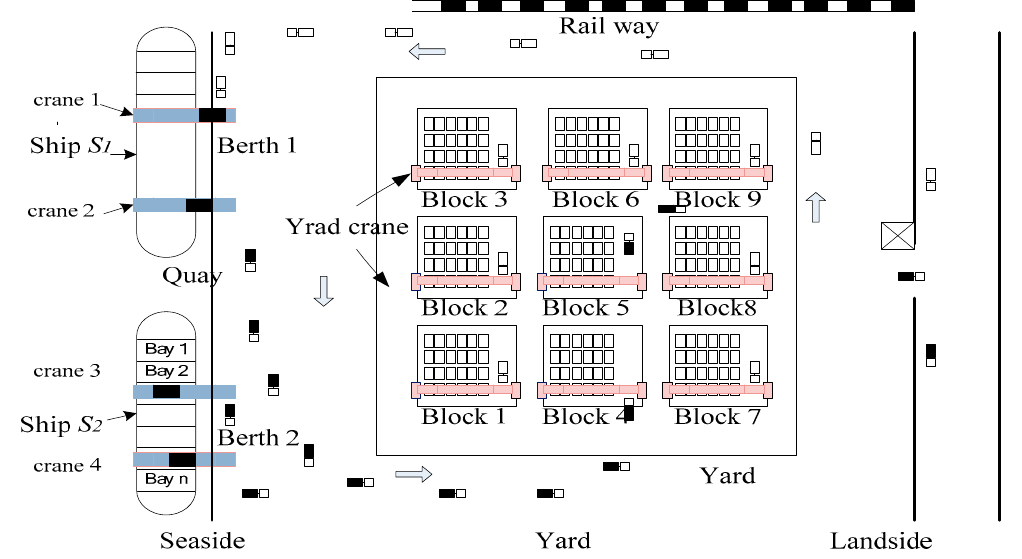
Figure 1. An example of a seaport container terminal.